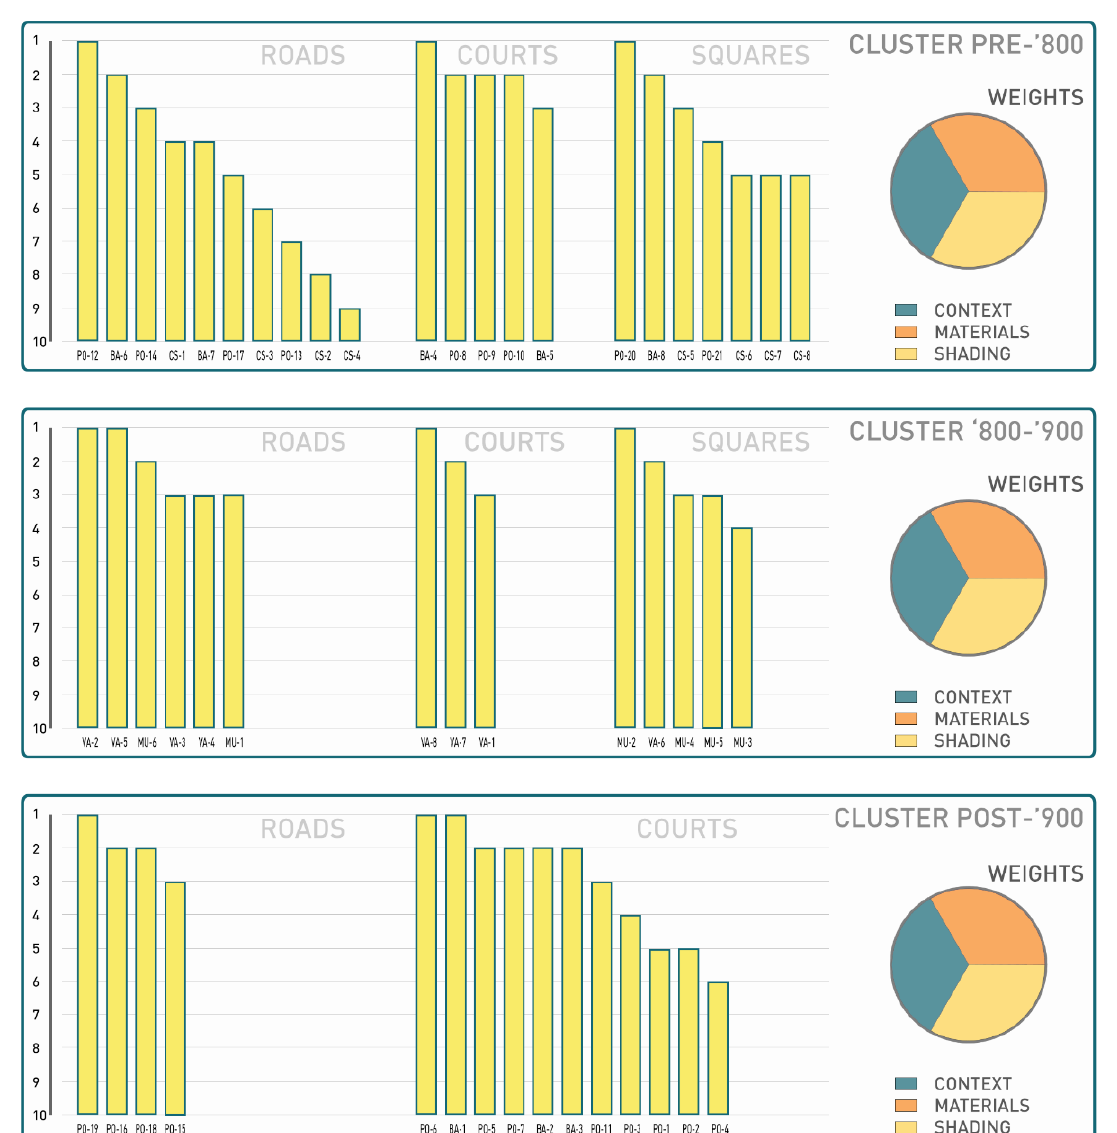
Figure 9. Multi-criteria analysis with a weighting of the criteria according to the order of preferability assigned to the indicators.